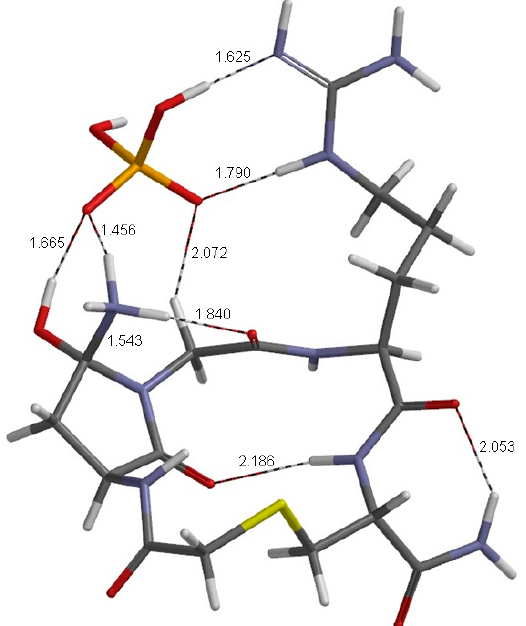
Figure 7. The geometry of TH2, the protonated tetrahedral intermediate directly connected to TS2 (Figure 8). Selected interatomic distances are shown in Å. Grey: carbon; white: hydrogen; blue: nitrogen; red: oxygen; orange: phosphorus; yellow: sulfur.